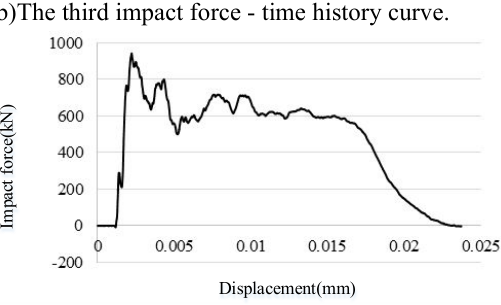
Figure 8. Impact force - time history curve of anti- creep